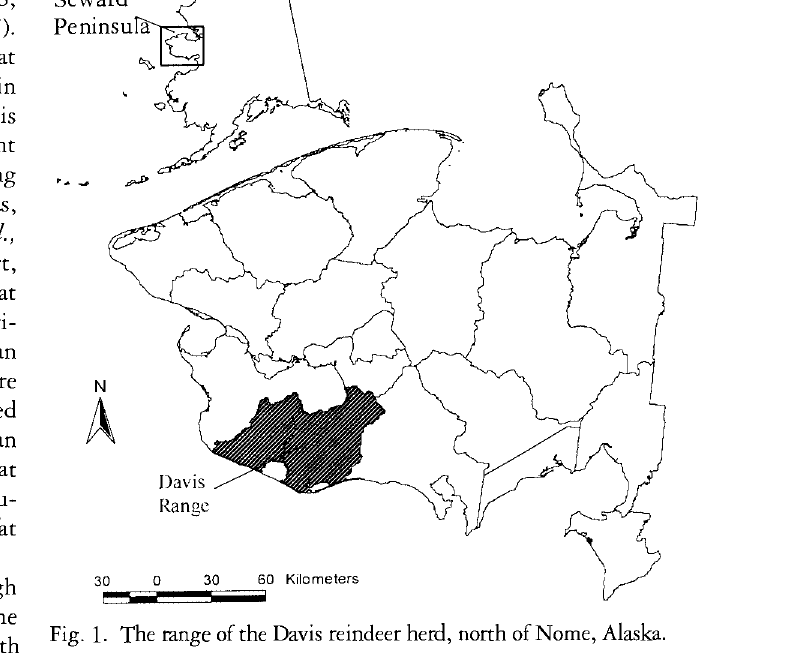
Fig. 1. The range of the Davis reindeer herd, north of Nome,